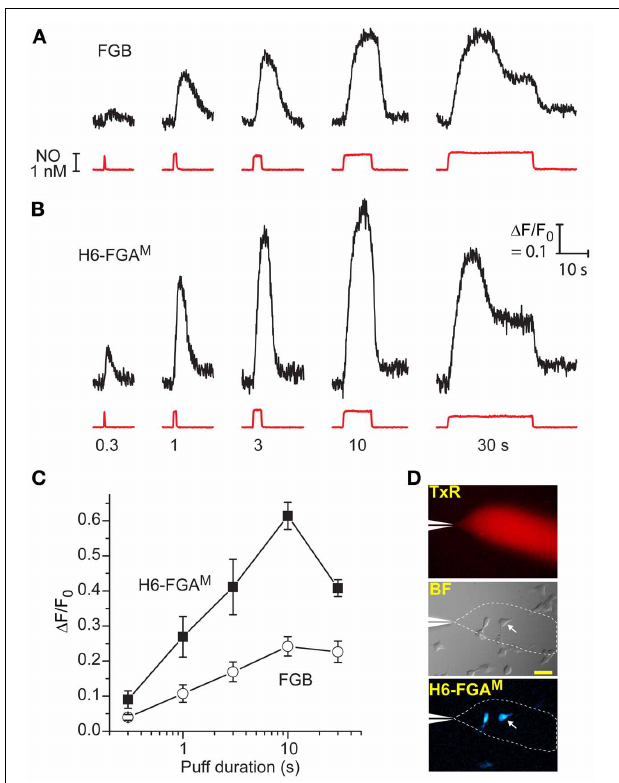
FIGURE 4 | Comparison between H6-FGA M and FGB as sensors of NO puffs when expressed in HEK GC / PDE5 cells. (A,B) Representative traces of fluorescence changes to NO puffs of different durations (black traces); the NO applications are quantified from the Texas Red dye intensity (red traces), with the applied durations specified underneath. There was a 5-min interval between applications and each result is from a single cell. Calibration (in B ) applies to both sets of data. (C) Mean responses ( ± SEM) to the different puff durations in four (H6-FGA M ) or seven (FGB) cells in three experiments. (D) Images showing the spread of Texas Red from the puffer pipette (top) within a field of cells (brightfield, middle), two of which are fluorescent (bottom); the arrowed cell is the source of the traces in (B) ; scale bar (middle) = 50 μ